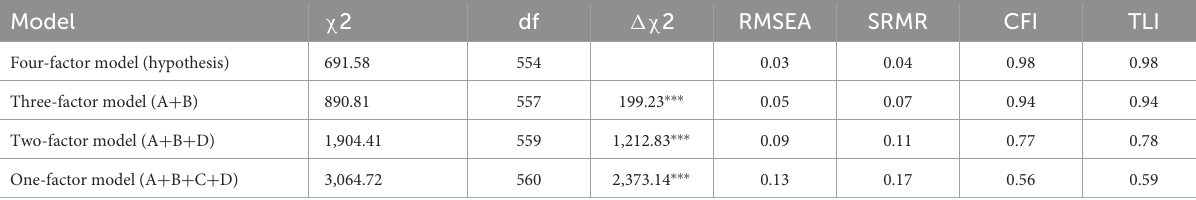
TABLE 1 Results of confirmatory factor analysis ( N = 282).